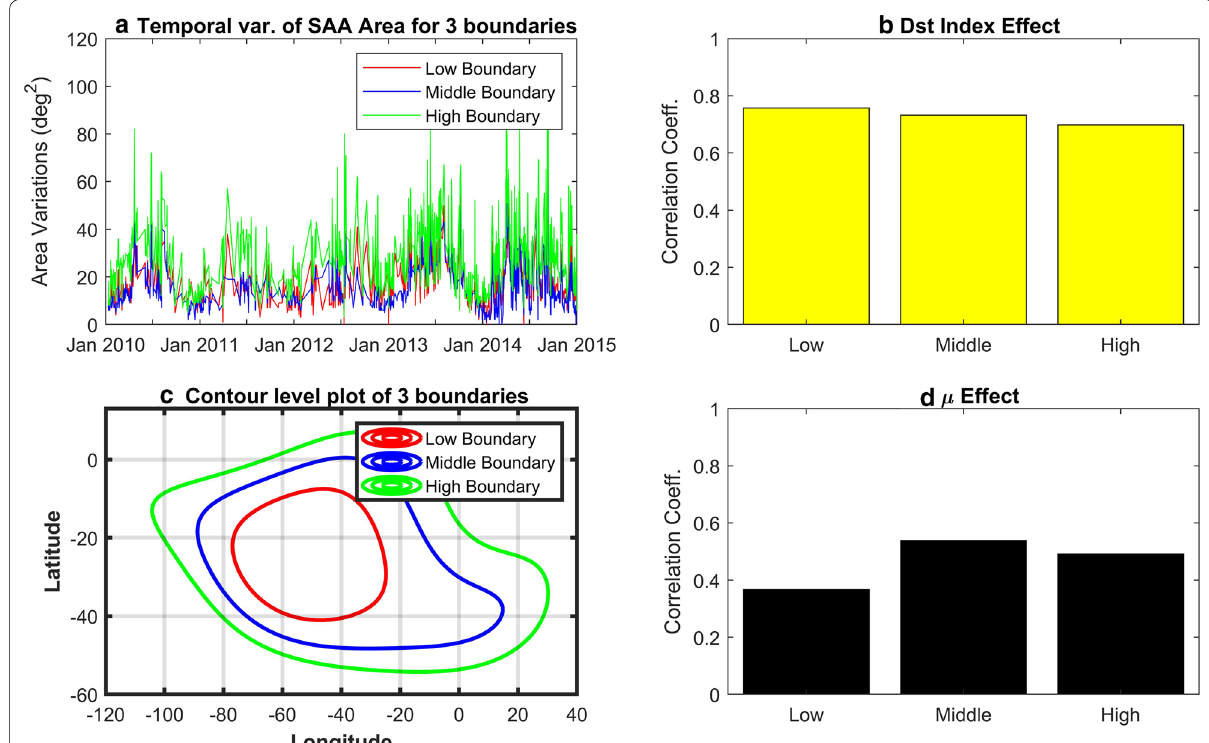
Fig. 12 Area threshold variation effect. a demonstrates the SAA area temporal variation, while c the contour plot level of each boundary. b, d illustrate the correlation coefficient between the SAA area, calculated based on the three different threshold values, the Dst index, and the geodipole tilting angle ( µ